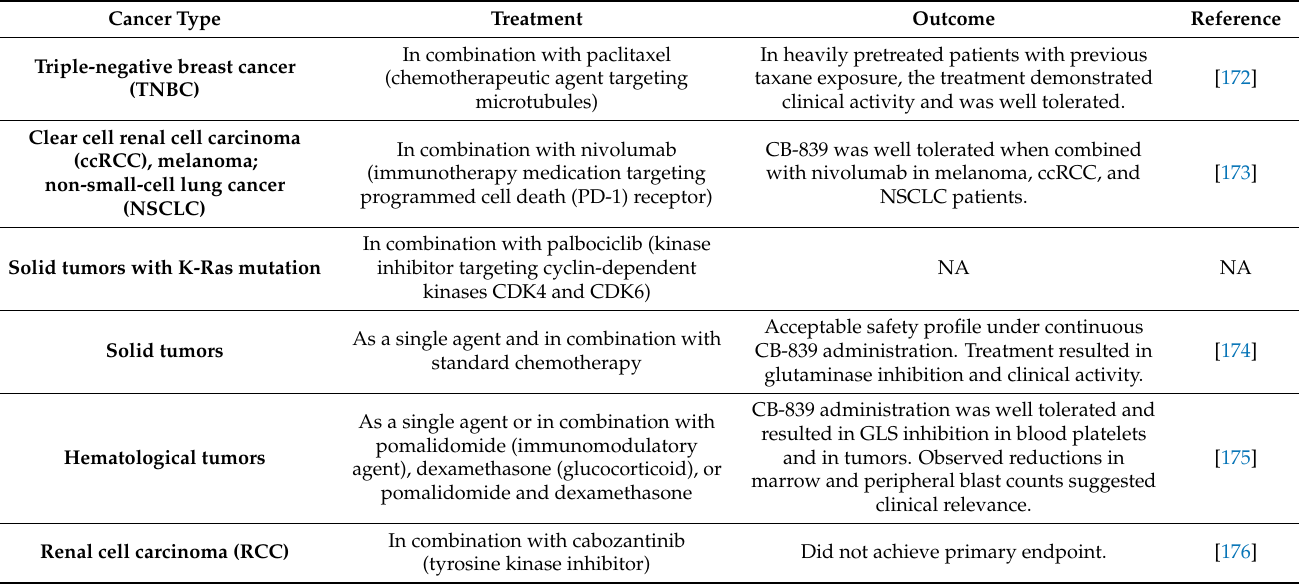
Table 2. Overview of completed clinical trials testing telaglenastat (CB-839) in various cancer